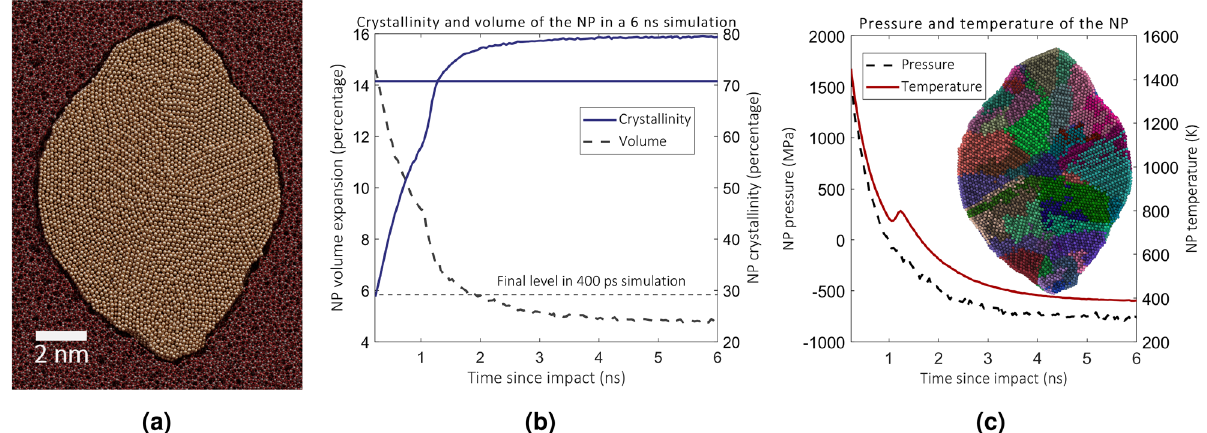
Figure 5. ( a ) Snapshot of the simulation cell after the 6 ns simulation. The cell is cut in half. A crystalline grain is clearly visible in the upper-right corner of the NP. Rest of the grain do in the ( b ) Crystal content and the volume of the NP as a function of time in the long MD simulation. Shown by the horizontal lines are the corresponding levels in the simulations without the long MD simulation between impacts. c) Shown is the temperature and the pressure of the NP. The inset shows colored grains that are identified using the grain segmentation tool in OVITO 46 .